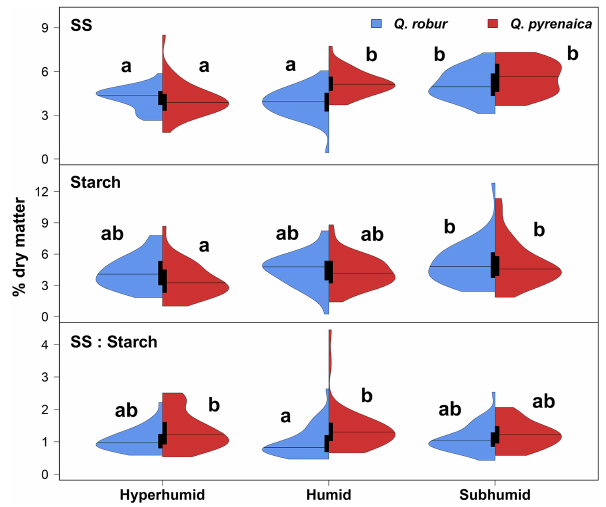
Figure 3. Distribution of soluble sugars (SS), starch concentrations, and SS-to-starch ratio, for Quercus robur ( N = 120) and Q. pyre- naica ( N = 120) at the three study sites. Horizontal lines represent the median, and black box plots show the extent of 25th and 75th percentiles. Lower-case letters indicate statistically significant dif- ferences along the gradient according to multiple pairwise compar- isons. Note that different scales are used on the y axis for each set of